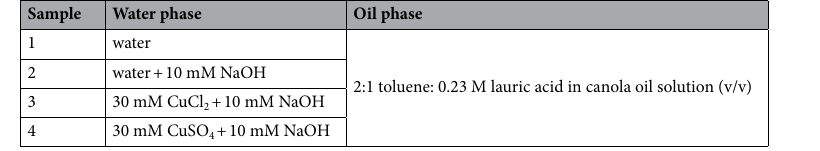
Table 1. Samples used for static interfacial tension